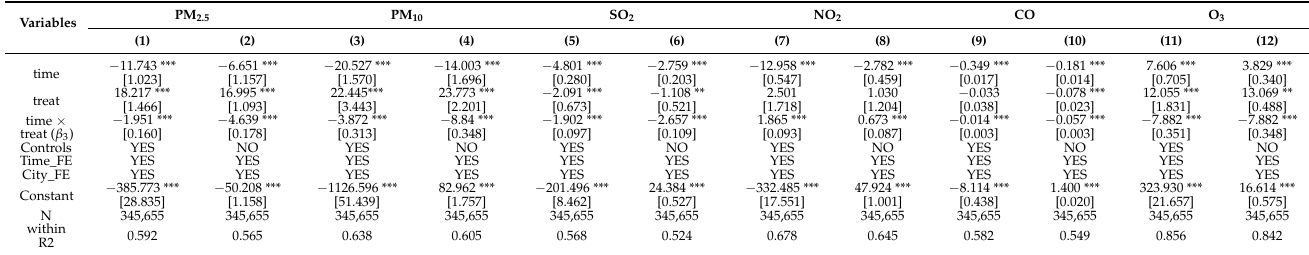
Table 2. Basic effects of BSDW policy on